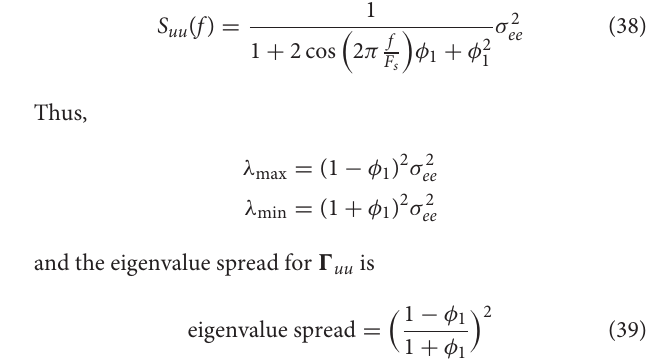
The numerical values of all associated parameters are listed in Table 3 . To incorporate a degree of uncertainty, for testing the robustness of a proposed controller, some parameters are defined as normally distributed random